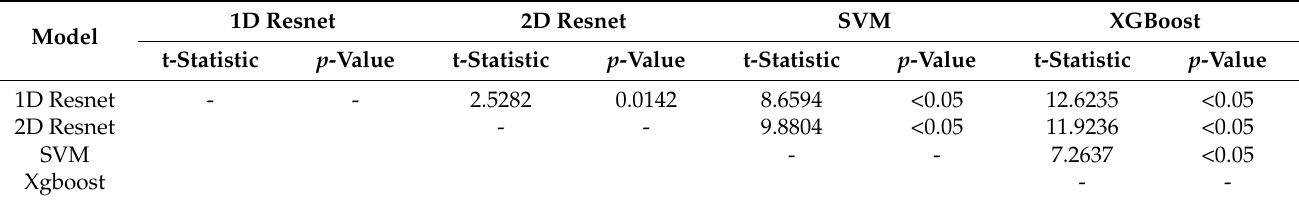
Table 3. Statistical result between different models based on pairwise t -test.